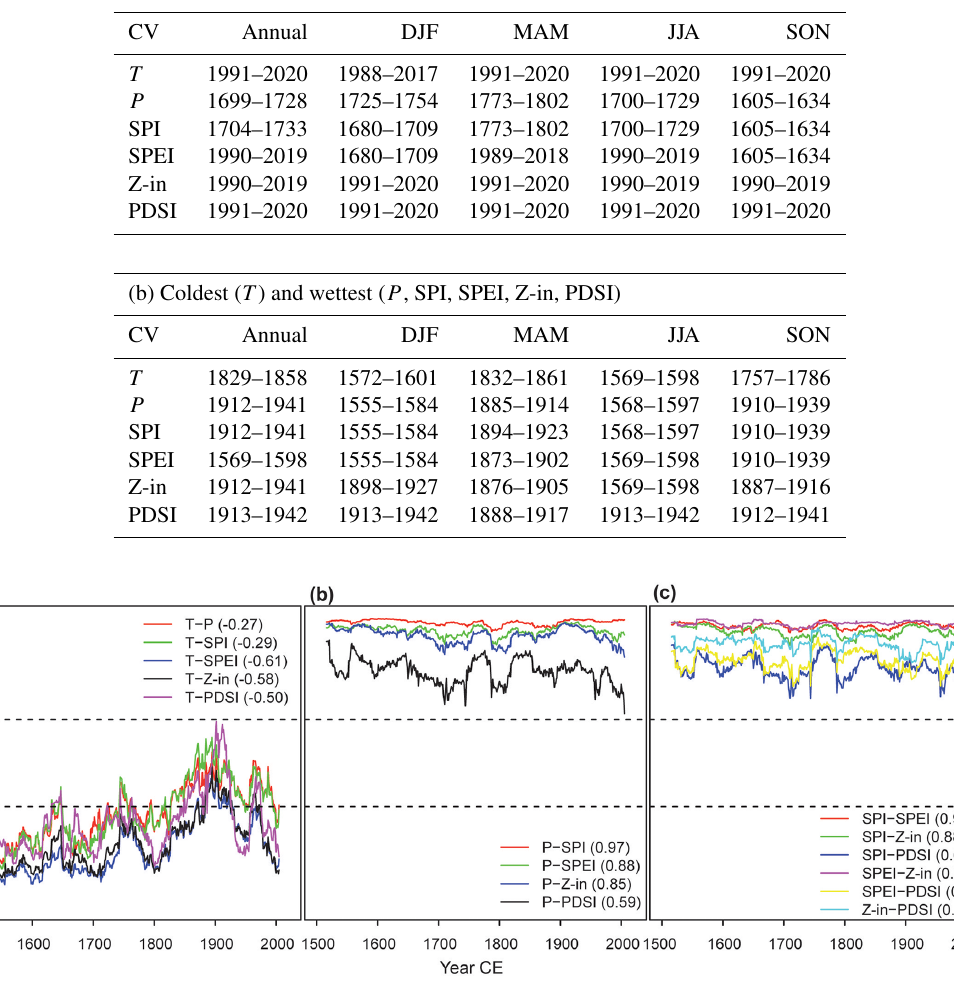
Figure 2. The 31-year running correlation coefficients between annual series of (a) temperature ( T ), (b) , precipitation ( P ) and (c) drought indices (SPI, SPEI, Z index, PDSI) in the Czech Lands in the 1501–2020 period. Correlation coefficients for the whole period are in brackets. Dashed lines indicate 0.05 significance levels: correlations above and below these levels are statistically significant.